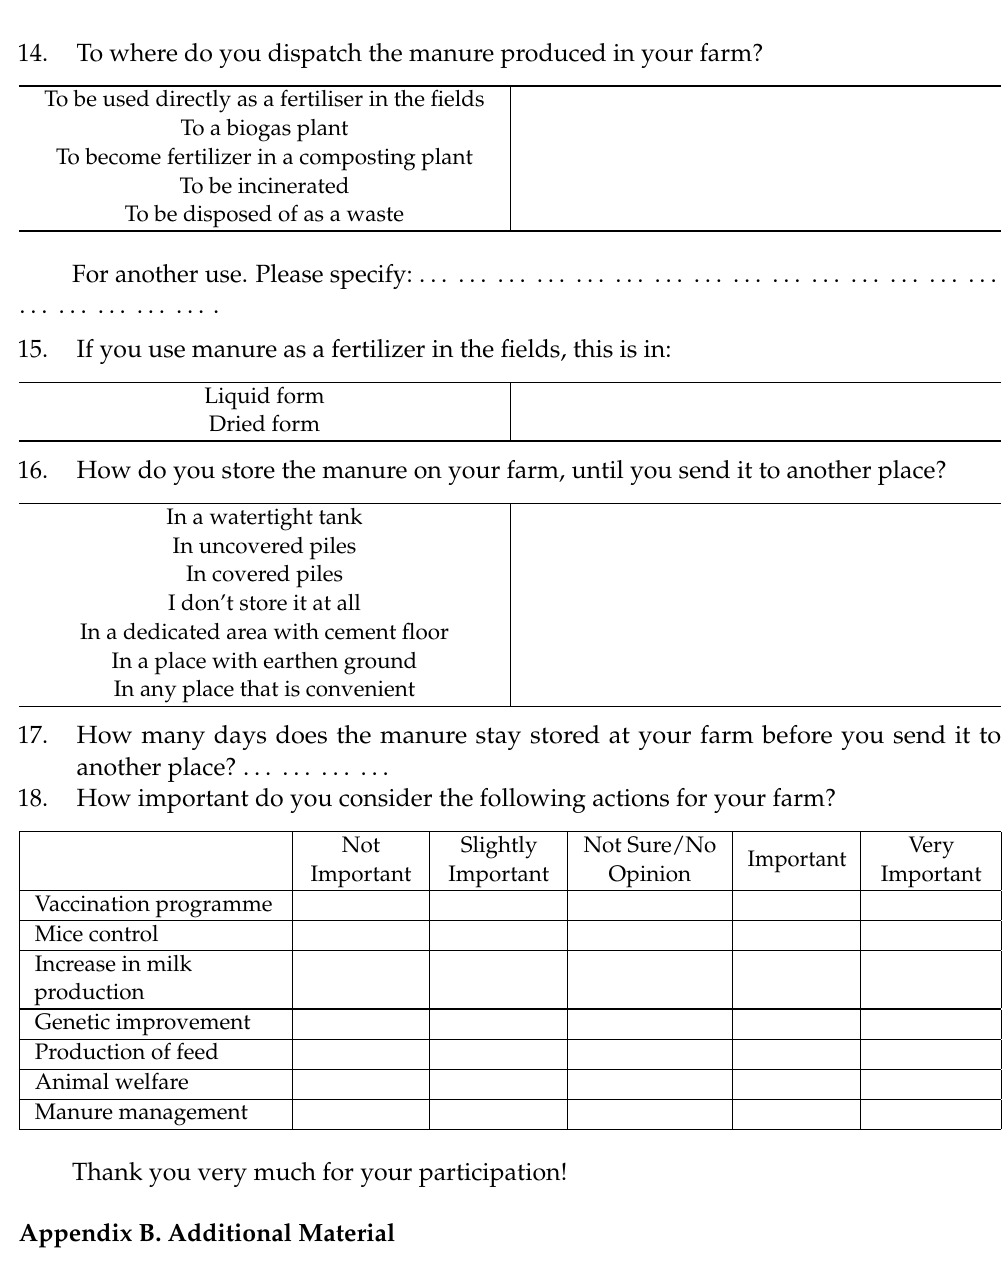
Table A1. Participants’ knowledge concerning safe manure management (Breakdown of the score to specific